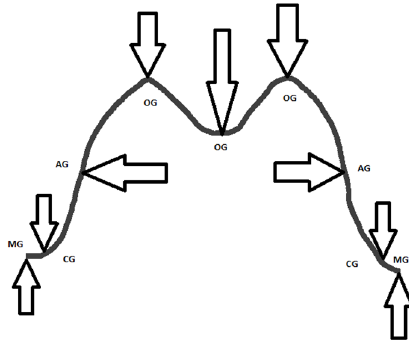
Figure 2. Measurement points.